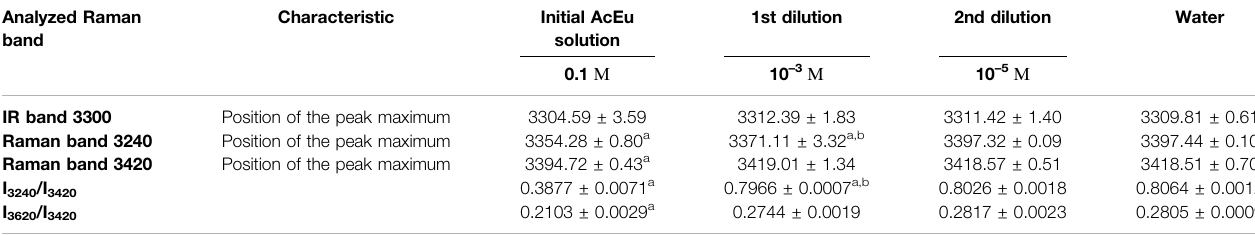
TABLE 1 | Characteristics of spectral bands of solutions associated with vibrations of bonds in water molecules (data are presented as mean ± se). Analyzed Raman band